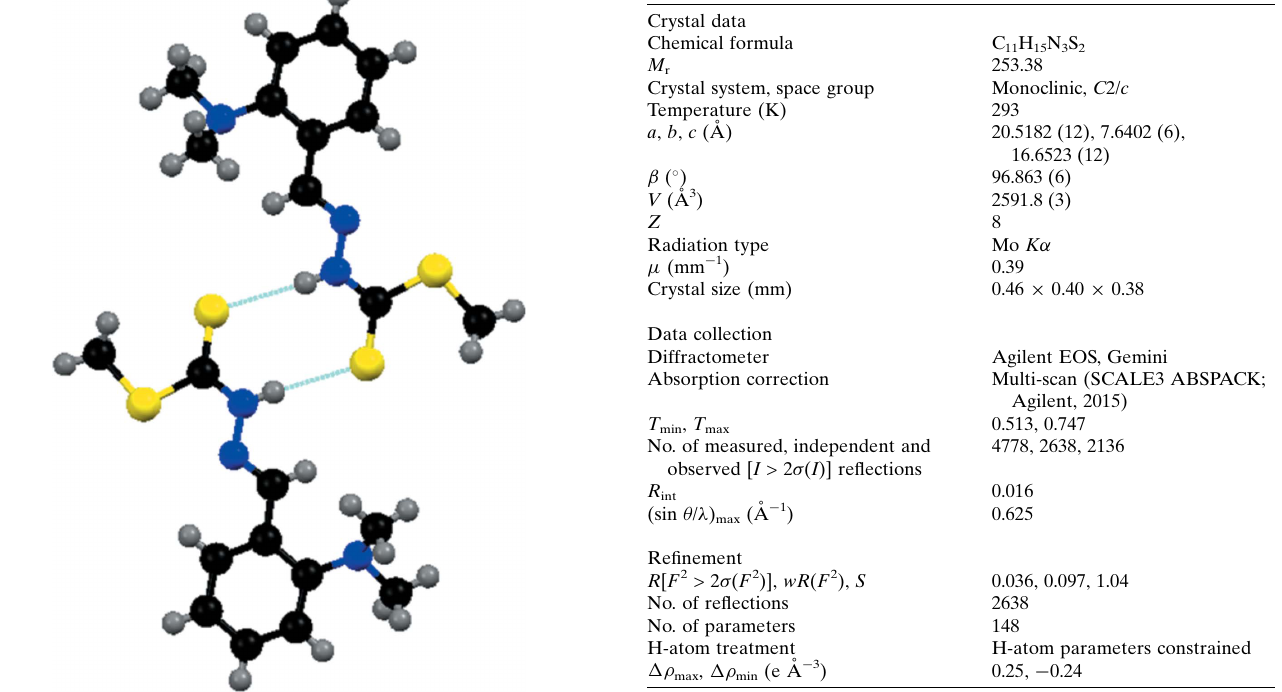
Table 2 Experimental details.